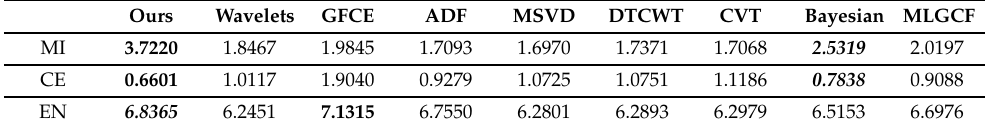
Table 4. Objective values of scenes with different